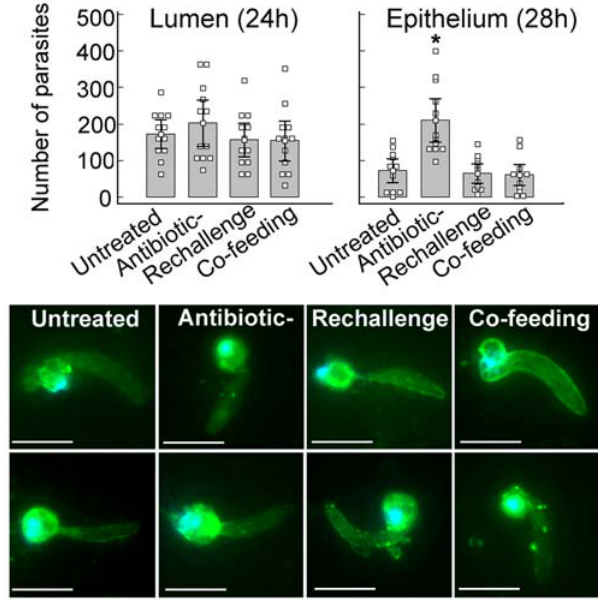
Figure 4. Ookinetes counts in the lumen or midgut epithelium of untreated septic, aseptic (Antibiotic), antibiotic treated mosquitoes that had been re-challenged with natural flora bacteria (Rechallenge), and mosquitoes that had been co-fed with live bacteria in the blood meal (Cofeeding) (upper panel). Points indicate the absolute value of ookinetes counts in individual midguts, and bars represent the mean value of ookinetes from two replicates where the standard errors are included. An asterisk denotes p , 0.01 , and p -value was calculated by a Kruskal-Wallis test. Lower panel: immuno-fluoresence staining of ookinetes in the midgut lumen 24 hrs post infection where midgut homogenates were stained with anti-Pfs25 antibody followed by Alexa Fluor 488-conjugated (green) goat anti-mouse antibody staining. Scale bars: 5 m m.